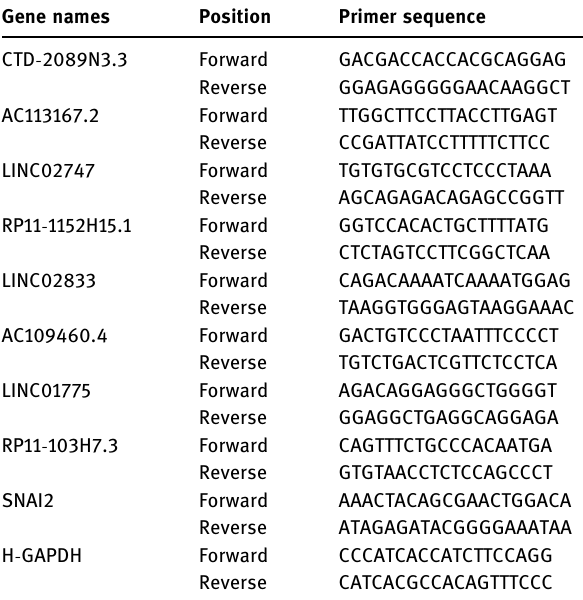
Table 1: Primers used for qPCR analysis of eight EMT -